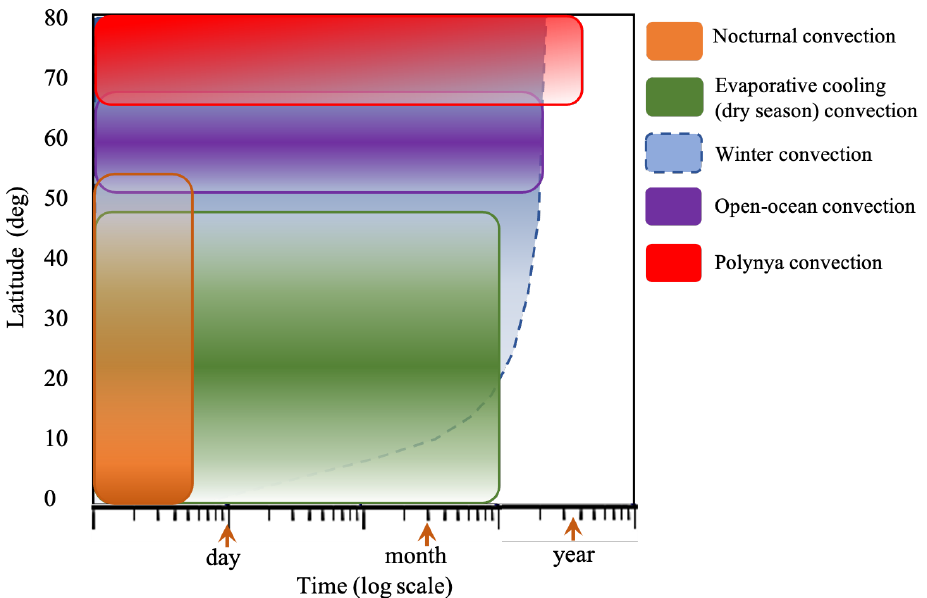
Figure 6. Schematic of different types of convection covered in this review, in terms of typical latitudes and time scales. Color opacity indicate where that type of convection is more common (darker) or less common (lighter). The solid line borders show the outer values that may reasonably see some occurrence of the convection type. The latitude shown is the absolute value, in other words the schematic holds for both the Northern and Southern Hemispheres. Note that open-ocean convection is mainly observed in the North Atlantic Ocean and polynya convection is strongest in the Antarctic